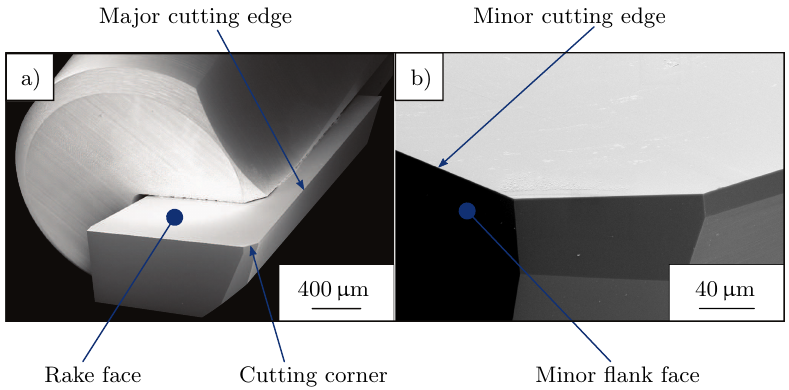
Figure 4. Geometry of an MCD-tipped tool ( a ) Overview of cutting part and ( b ) Detailed view on rake face and cutting